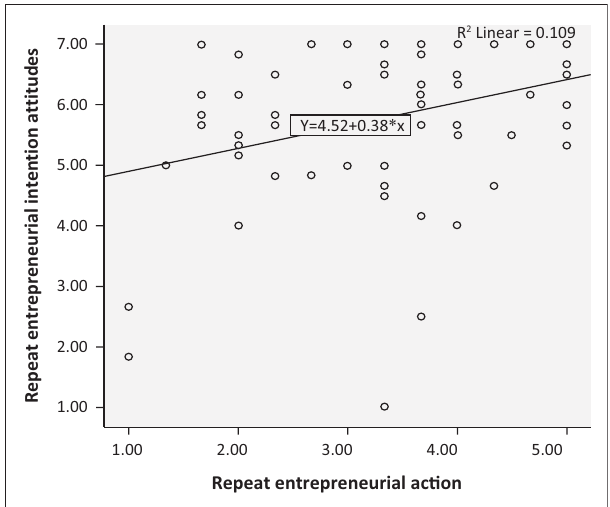
FIG URE 5: Scatter plot showing the relationship between recurring entrepreneurial intention attitudes and recurring entrepreneurial action.